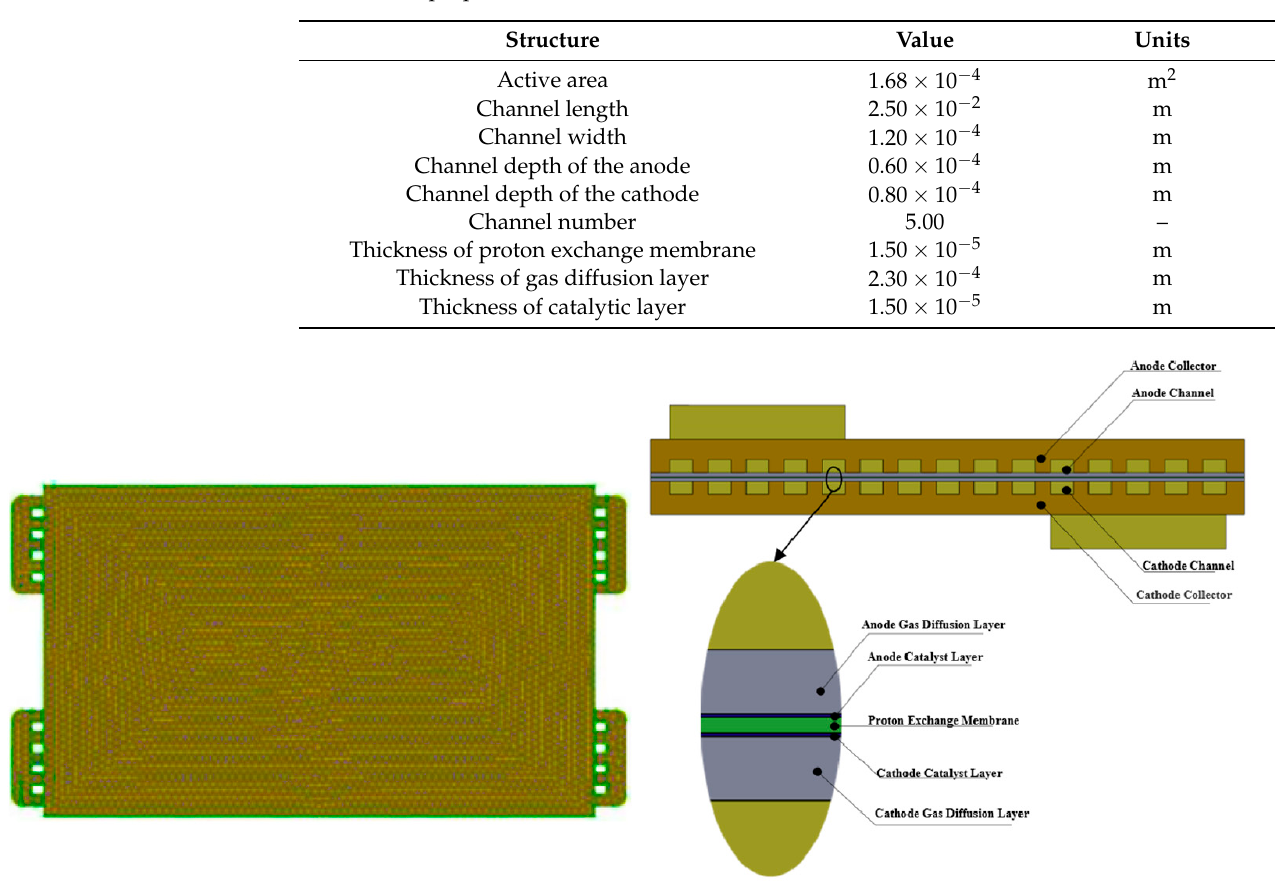
Table 1. Cell properties of the fuel cell model.